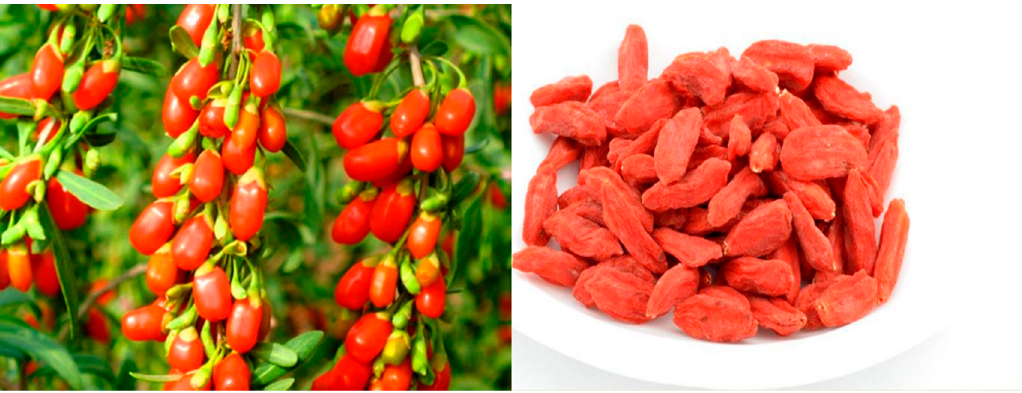
Figure 1. The fresh ( left ) and dried form ( right ) of Lycium barbarum fruit.